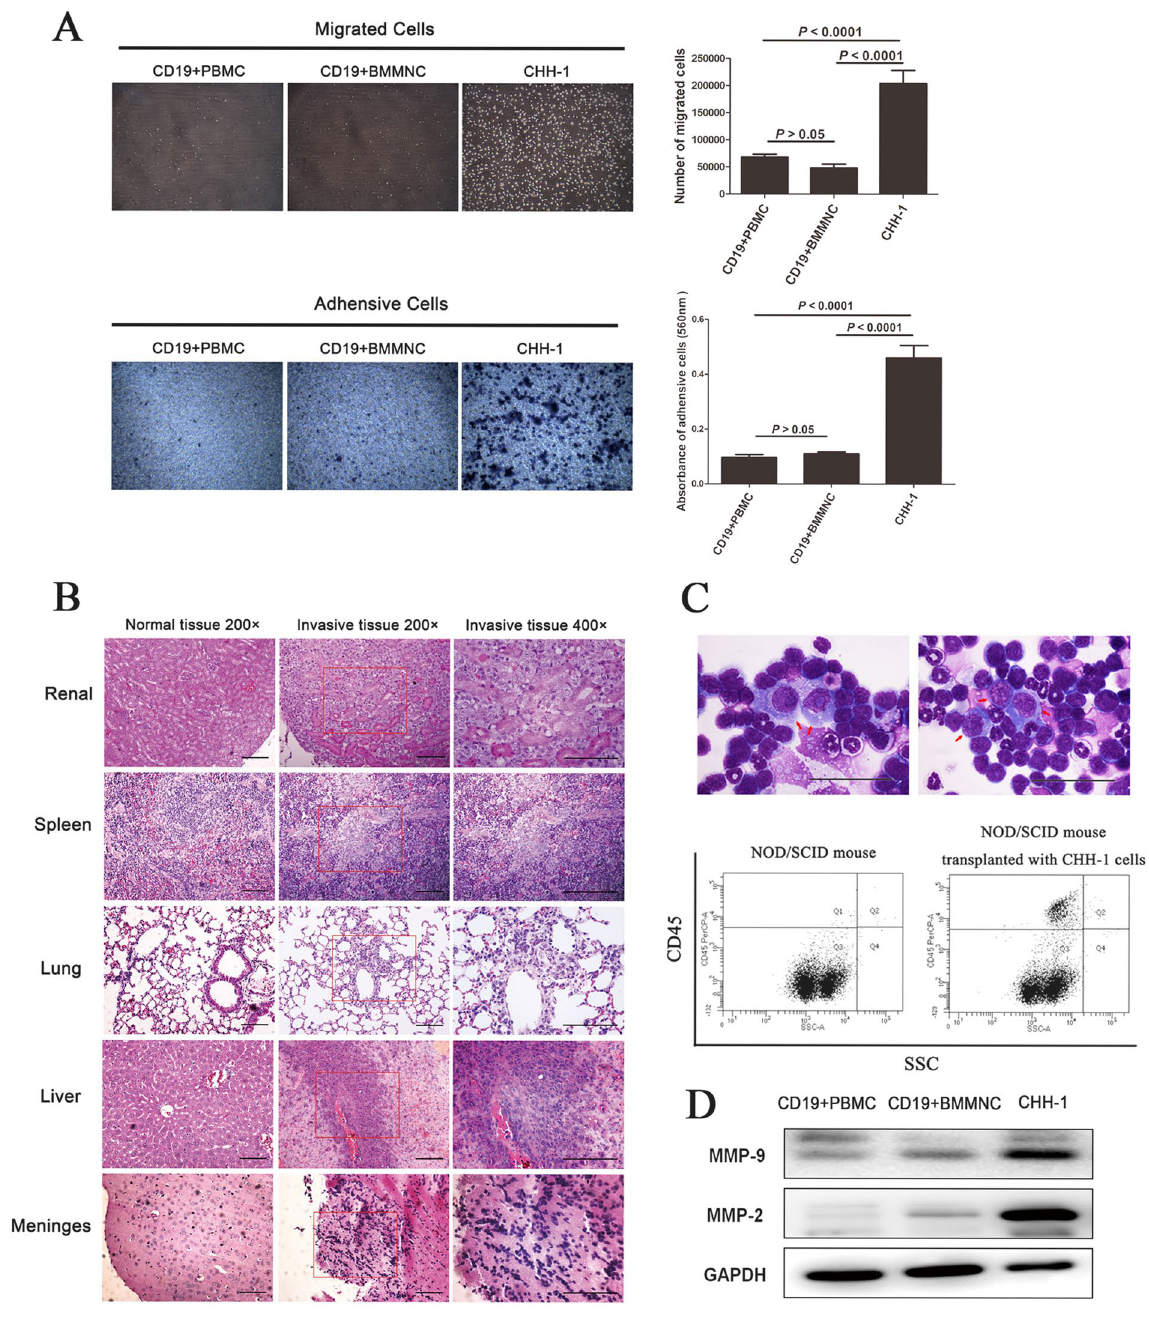
Figure 4. Invasive ability of CHH-1 cells. ( A ) The number of CHH-1 cells passing through or adhering on the transwell chambers coated with Matrigel is significantly greater than that of the control cells. Data represent the mean ± SD of three independent experiments. CD19 + PBMCs and CD19 + BMMNCs derived from the normal human are used as control cells. ( B ) Histopathology of CHH-1 cells invading in the kidney, spleen, lung, liver and meninges of NOD/SCID mice is observed 40 days after injection of 5 × 10 5 cells into the tail vein ( n = 6, the results are representative of two separate experiments). ( C ) CHH-1 cells with representatively atypical morphology are observed (arrow indicated) in the NOD/SCID mice bone marrow centrifuged smears, and the engraftment presented as human CD45 + cells (Q1 + Q2) in the mice bone marrow is detected by flow cytometry 40 days after transplantation via tail vein ( n = 6). ( D ) Overexpression of MMP-9 and MMP-2 in CHH-1 cells is assayed by Western blot. GAPDH is used as an internal control. Original magnification: × 200, × 400, scale bar 100 μ m ( A , B ), × 1000, scale bar 50 μ m ( C